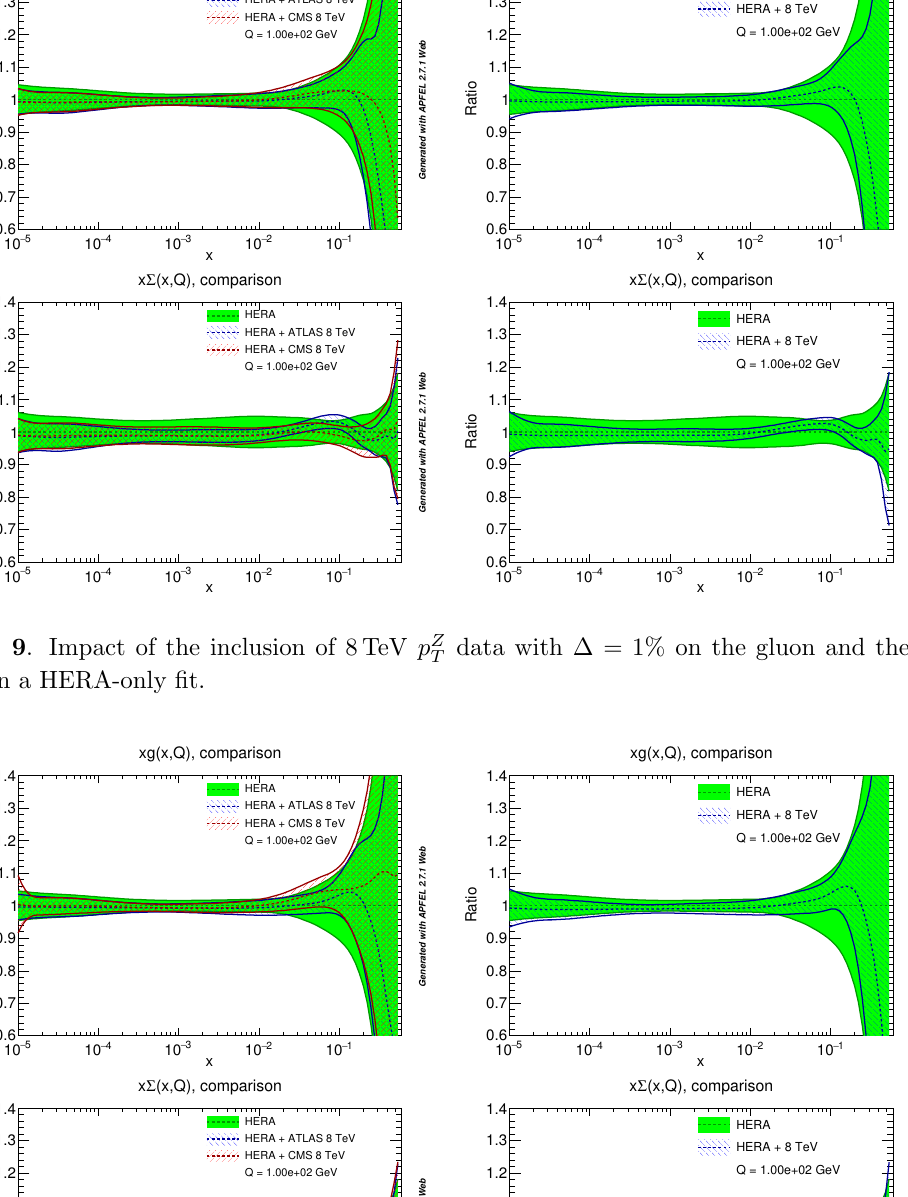
Figure 10 . Impact of the inclusion of 8 TeV Z pT data with (cid:1) = 0% error on the gluon in a HERA-only (cid:12)t.